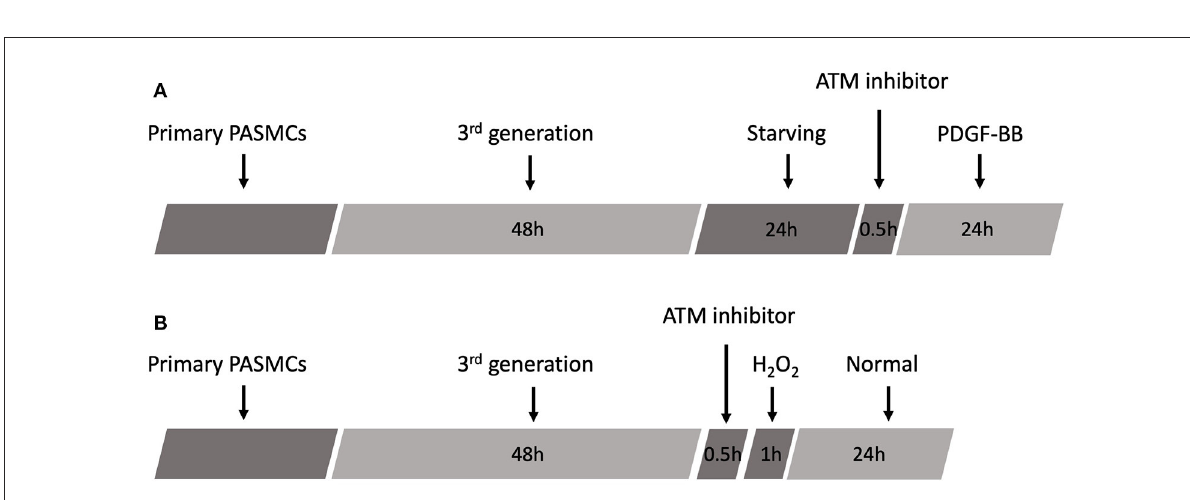
PASMCs was cultured on the cover glass for a 48-well